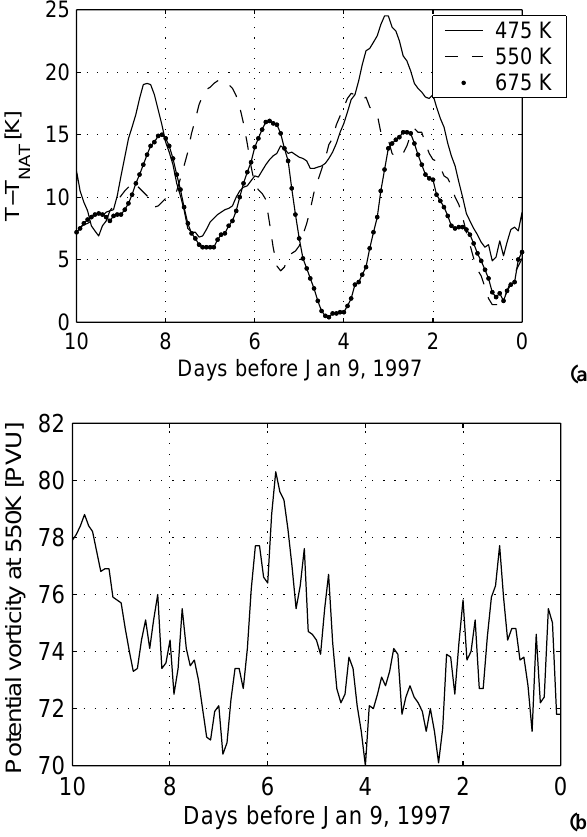
Fig. 7. Temperatures (a) and potential vorticity (b) along ECMWF backtrajectories from Kiruna for 9 January 1997.